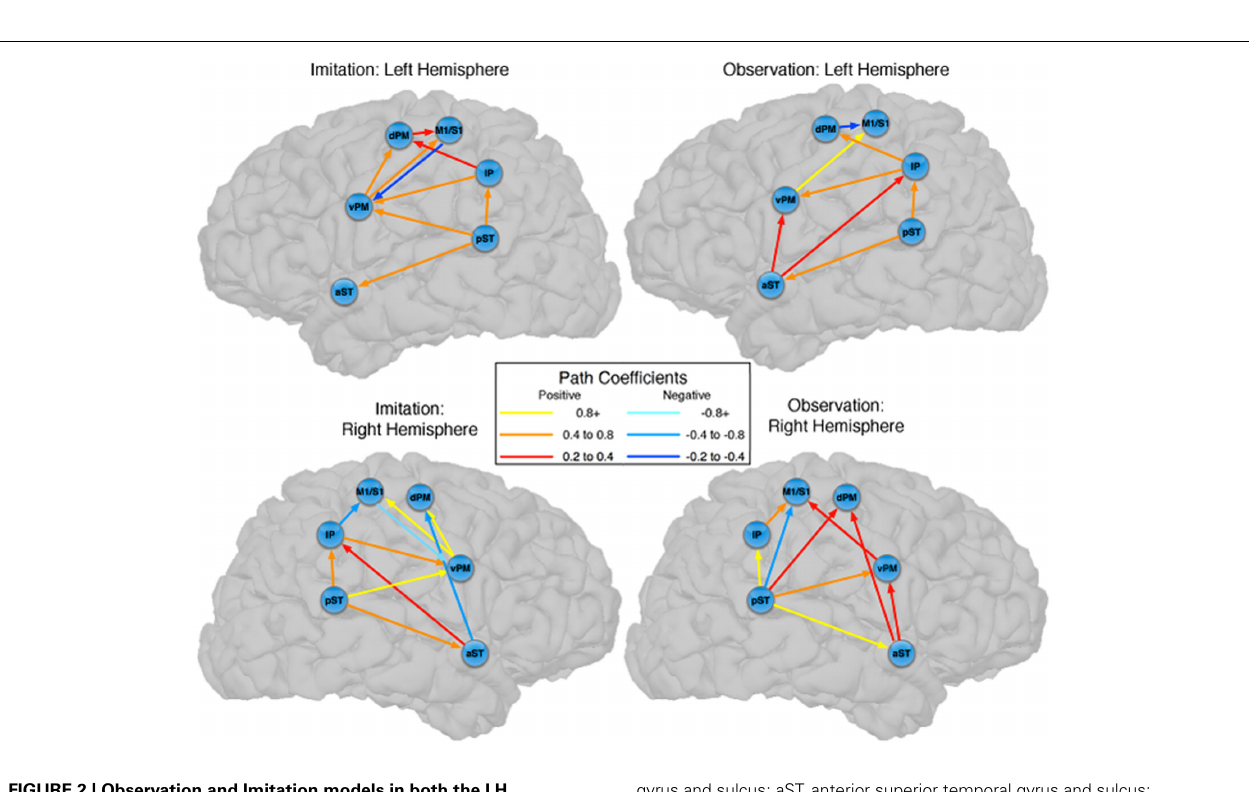
FIGURE 2 | Observation and Imitation models in both the LH and RH with connections between pST, aST, IP, vPM, dPM, and M1S1. IP, inferior parietal lobule. M1S1, primary motor/somatosensory cortex; pST, posterior superior temporal